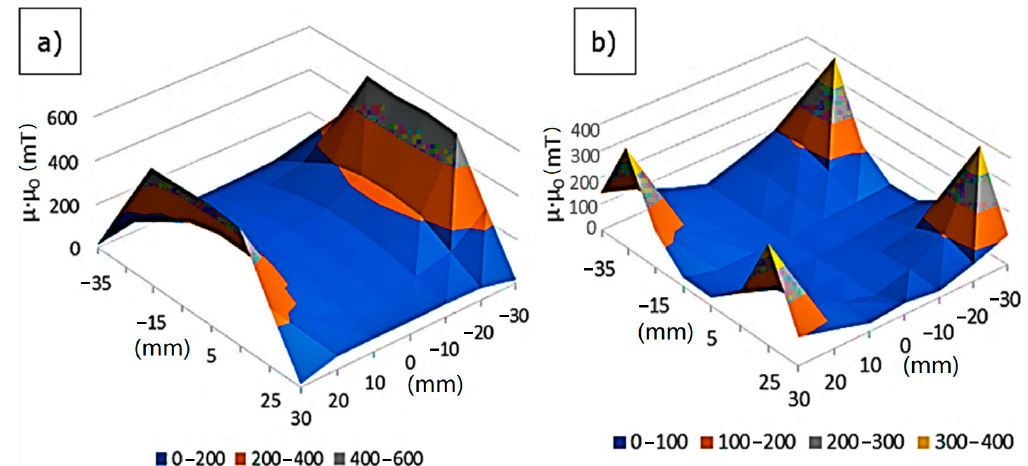
Figure 6. Magnetic field strength distribution in a system for casting mold mass: ( a ) longitudinal measurement, ( b ) cross magnetic field measurement.